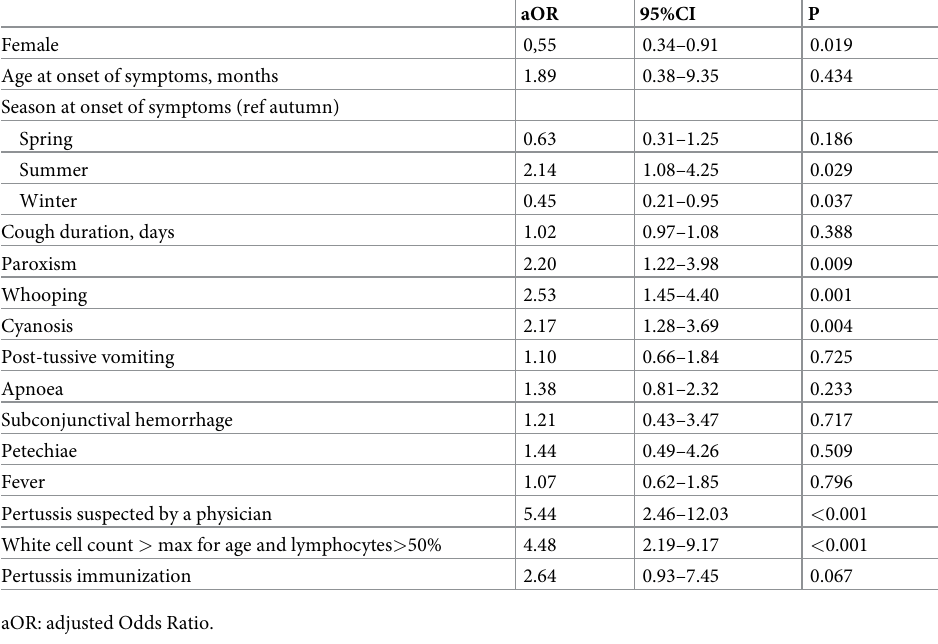
Table 2. Variables associated with positive RT-PCR for pertussis through multivariable logistic regression analy- sis (aOR; 95% CI).